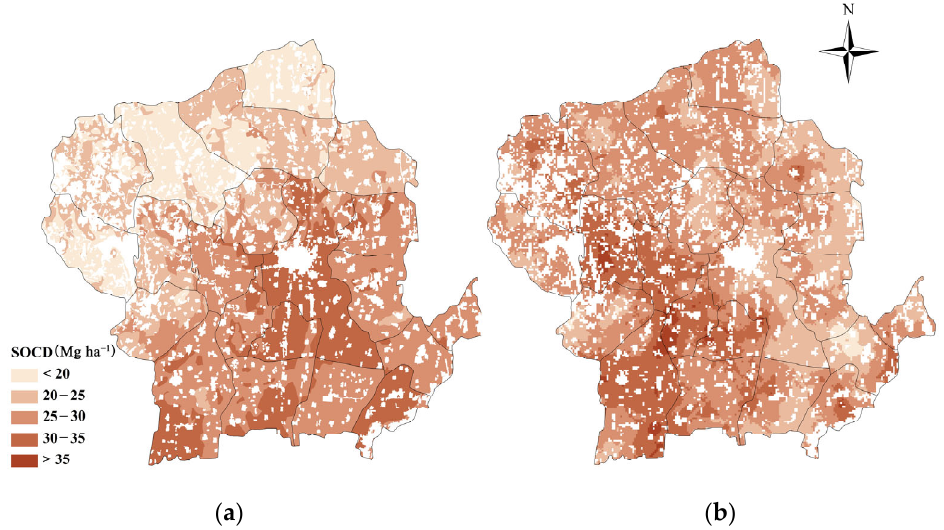
Figure 5. Distribution of soil organic carbon density (SOCD) in Cangshan County in 2008 estimated ( a ) by CENTURY modeling (assuming all cropland under a wheat–maize rotation); ( b ) by interpolation from regional sampling in 2008.